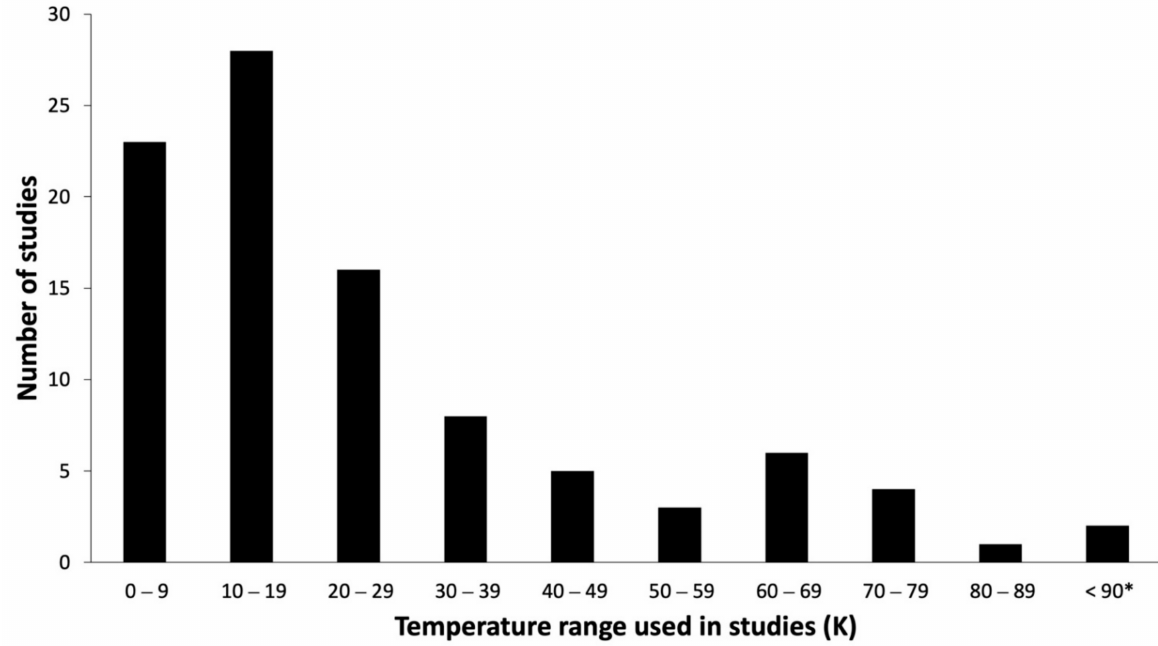
Figure 8. Number of studies binned by temperature range used (difference between the highest treatment temperature, excluding the negative control, and the lowest temperature). * Includes temperature ranges between